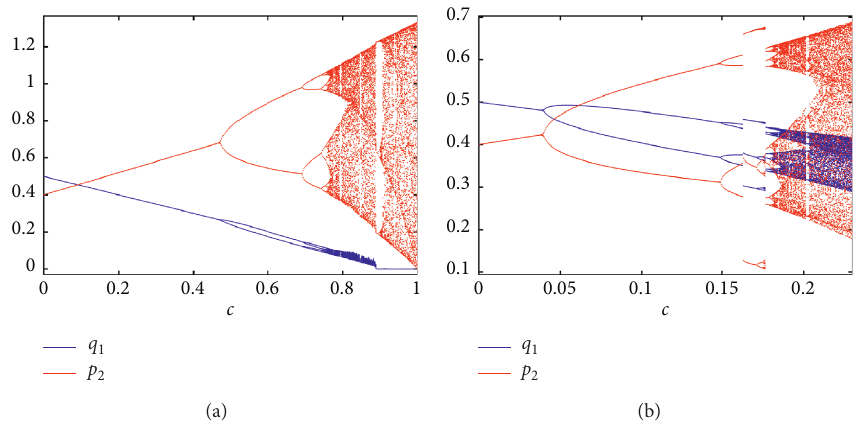
Figure 10: Bifurcation diagrams with respect to c when α � 1 . 5 and (a) β � 1 . 5 and (b) β � 2 . 6.